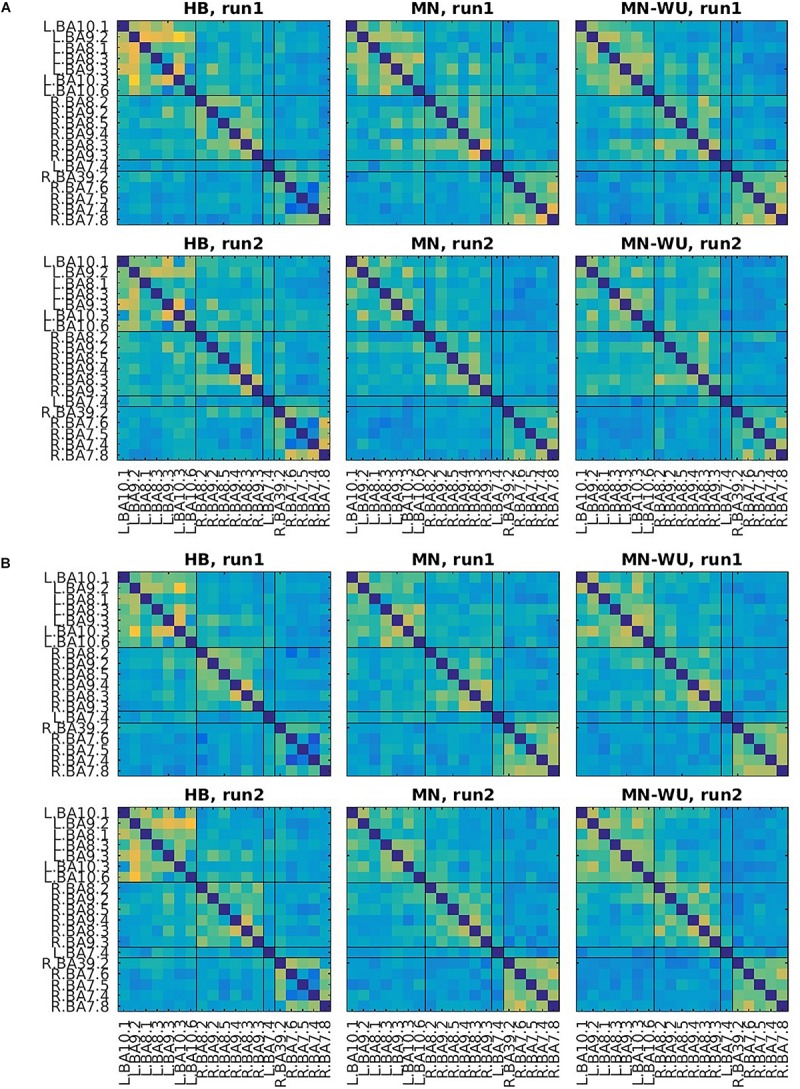
SD maps of RSFCs for run 1 and run 2. SDs of correlation matrices are computed across subjects for (A) oxy-Hb and (B) deoxy-Hb. The upper and lower rows correspond to run 1 and run 2, respectively. ROIs are displayed in the same order as those in Figure 6.